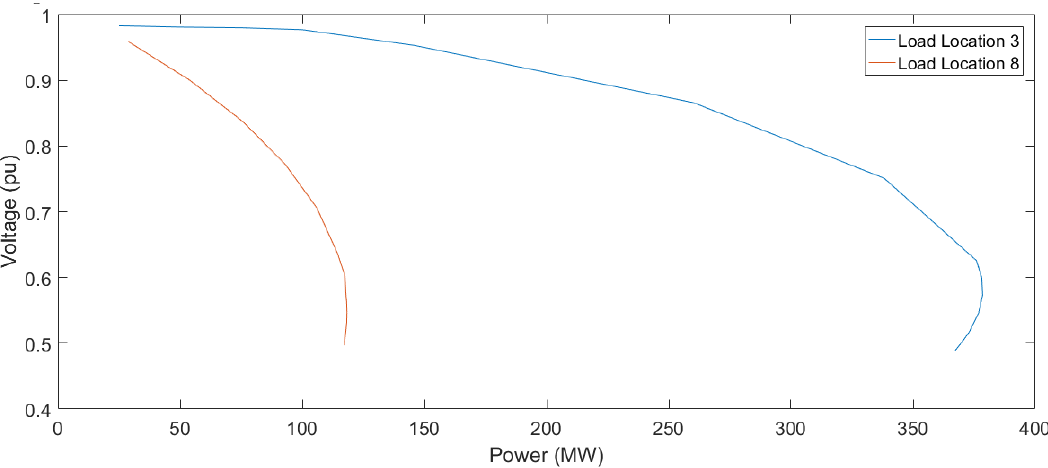
Figure 6. Nose curves for load location 3 and 8.